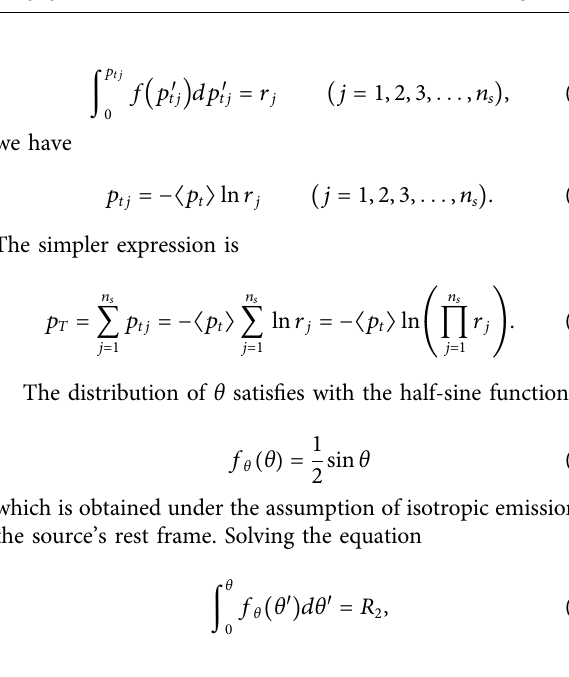
FIGURE 2 | The differential cross-section d σ / d | t | in | t | of c * p → π + n process produced in ep collisions at beam energy of 6 GeV at different Q 2 and x B shown in the panels. The symbols represent the experimental data measured by the CLAS Collaboration [38] and the curves are the statistical results obtained as those in Figure 1 .